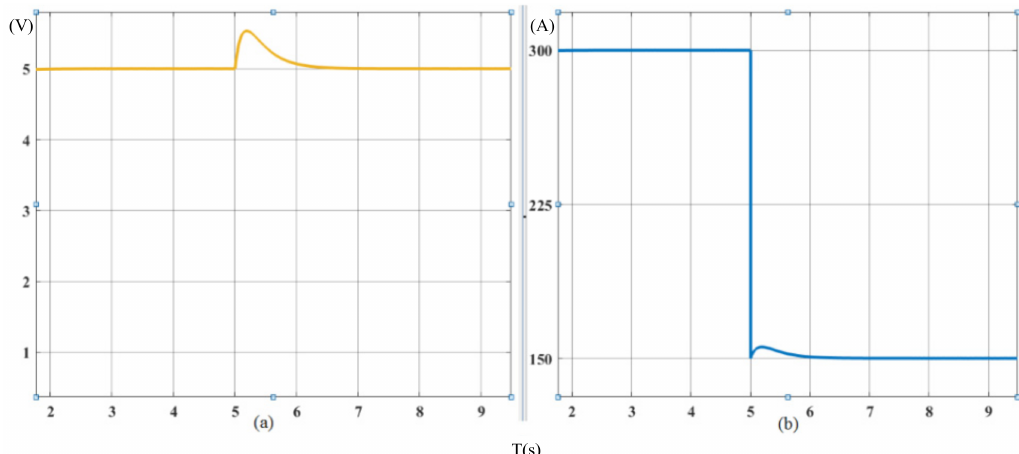
Figure 16. DC output waveforms controlled by the direct power control method when the load suddenly decreases: ( a ) voltage waveform; ( b ) current